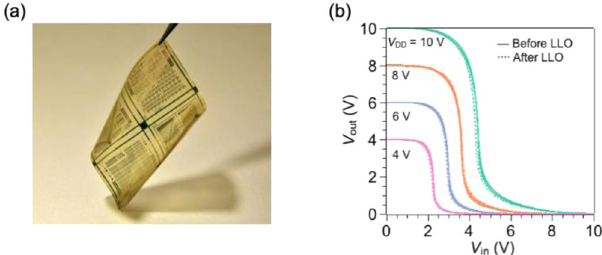
Fig. 4 Properties of the hybrid inverter before and after delamination from glass supports. a Photograph of the hybrid circuits on a free-standing PI fi lm. b VTCs of the hybrid complementary inverter with p- and n-channel W / L values of 200 µ m/9 µ m and 200 µ m/13 µ m, respectively, before and after